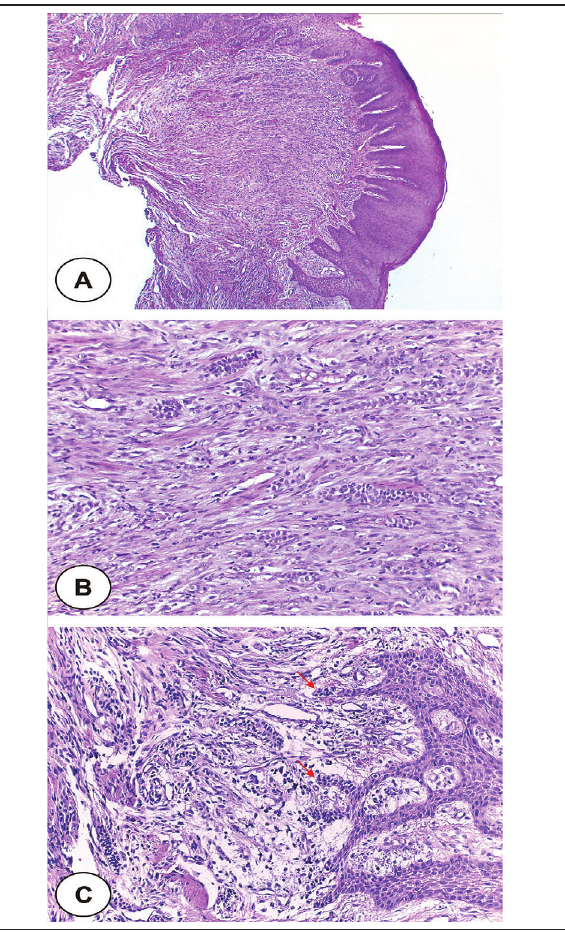
Figura 3 − Lesão revestida com epitélio escamoso hiperplásico, exibindo focos de degeneração hidrópica, espongiose e exocitose (A) – HE, ampliação original 40 × . Tecido conjuntivo fibroblástico celularizado com numerosas ilhas e cordões de epitélio odontogênico, entremeado por um discreto infiltrado inflamatório mononuclear (B) – HE, ampliação original 100 × . Detalhe do brotamento (setas vermelhas) da camada basal do epitélio superficial (C) – HE, ampliação original 200 × HE: hematoxilina e eosina.